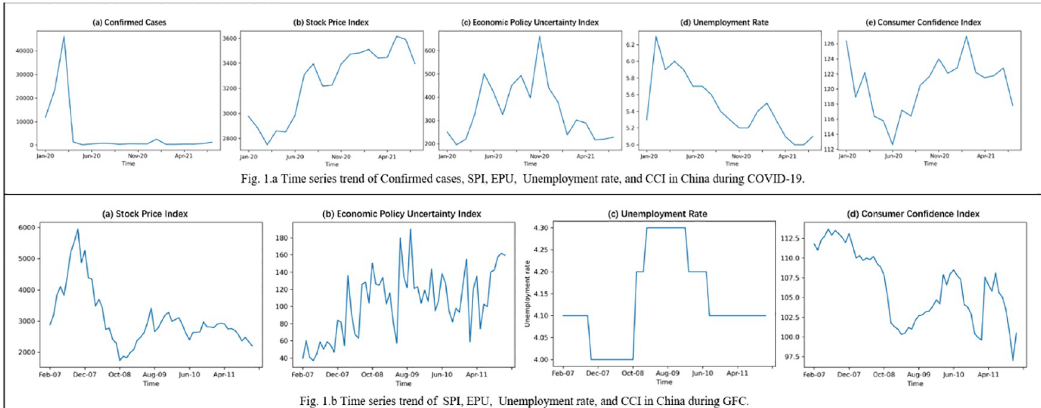
Fig 1. Time series trend of economic indicators in China during GFC and